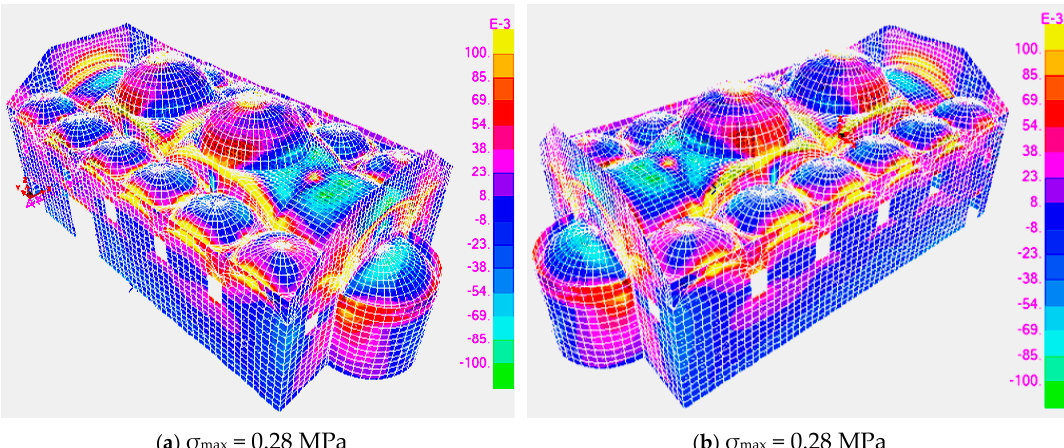
Figure 11. Non-deformable foundation ( a ) distribution of maximum tensile stresses South-East view ( b ) distribution of maximum tensile stresses North-East view. The scale at the far right of each plott indicates that the colours used to represent stress values in this numerical representation of the structure are ranging from 0.1 MPa to − 0.1 MPa. Yellow colour indicates stress values excedding 0.1MPa.